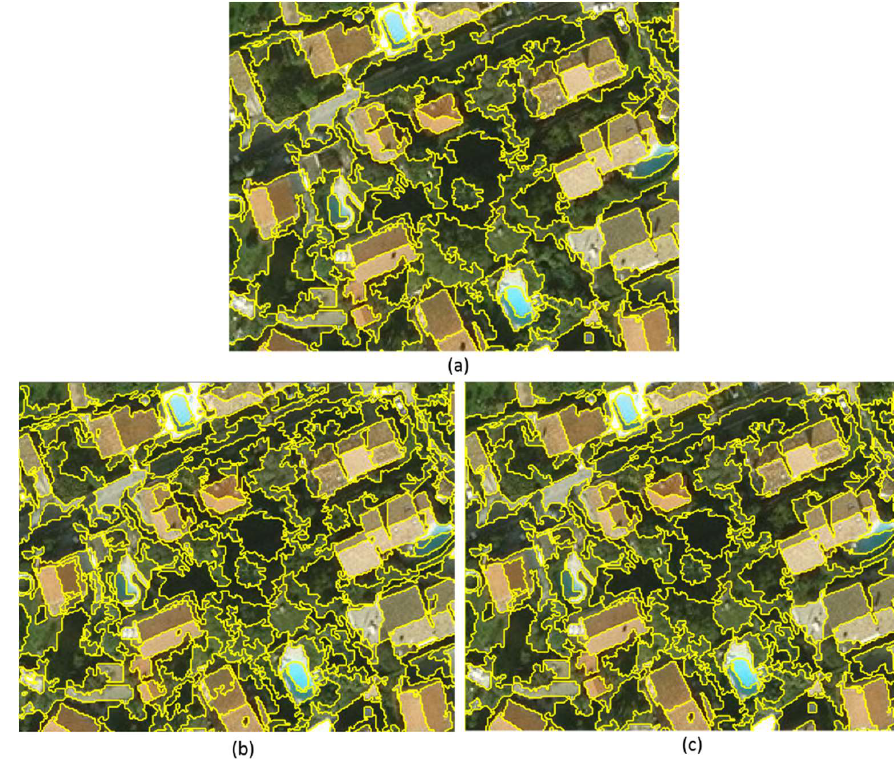
Figure 15. Subsets of the segmentation results with the optimal scale obtained by different UE methods: ( a ) proposed method, ( b ) Zhang method and ( c ) Espindola method.